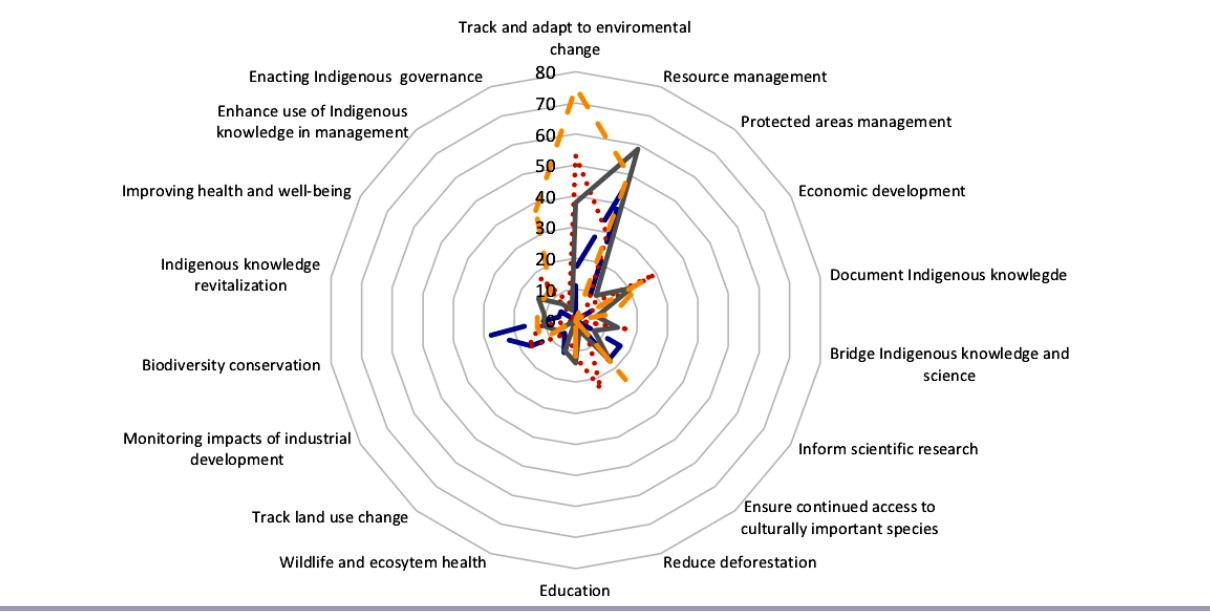
Fig. 4 . Percentage of monitoring initiatives at each level of Indigenous participation, displayed according to monitoring objectives. Initiatives are classified according to the degree of participation of Indigenous people: the blue dashed line indicates externally driven initiatives with Indigenous people as data collectors (IP1); the orange dotted line indicates collaborative initiatives with Indigenous people playing some role in design and execution (IP2); the grey solid line indicates collaborative initiatives with Indigenous people playing a strong role in design, execution, and management (IP3); and the yellow dashed line indicates autonomous monitoring by Indigenous people with some external support